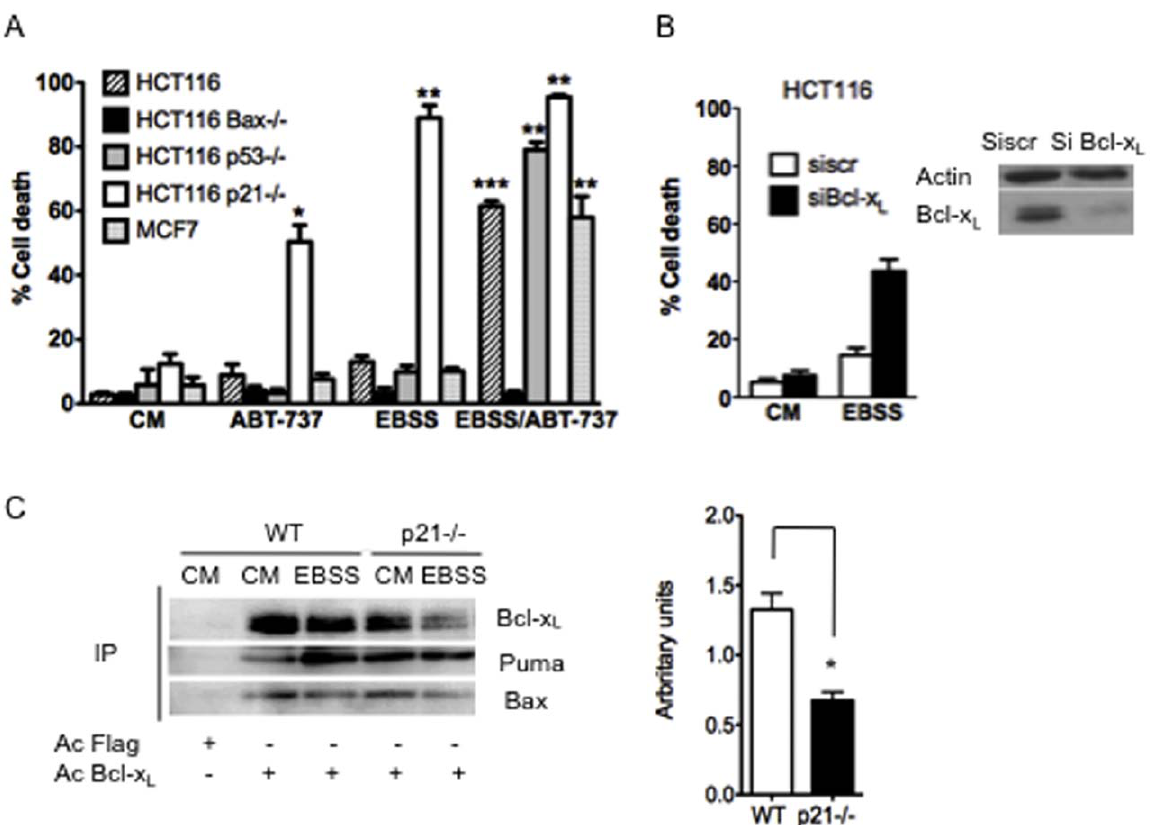
Figure 6. Sensitization to starvation induced cell death by down regulation or inhibition of Bcl-x L . (A) Inhibition of the BH3 domain of Bcl-2/Bcl-x L sensitizes starved cells independently of p53. The indicated cells were placed in complete medium (CM) or starved in EBSS medium for 24 h (EBSS) and treated with 1 m M of ABT-737 or not and cell death determined by blue trypan assay (**, ***, significantly different from cells placed in complete medium). (B) HTC116 cells were transfected with the indicated siRNA. 48 h later, cells were starved in EBSS medium for 24 h (EBSS) or not (CM). Western analysis of Bcl-x L was performed and cell death assayed by a trypan blue-staining. (C) Wild-type and p21 2 / 2 HCT116 cells were